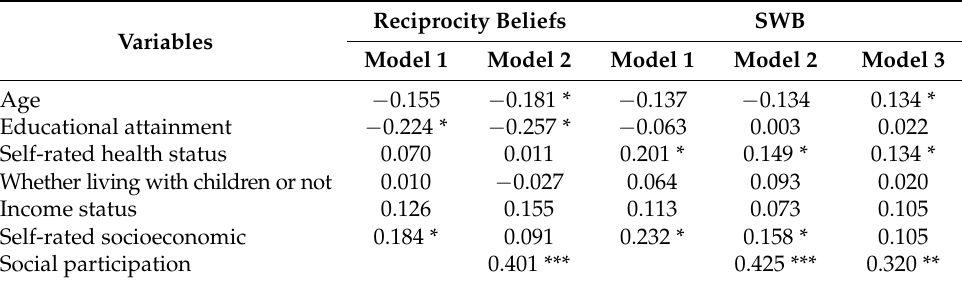
Table 4. Multiple linear regression analysis results in older